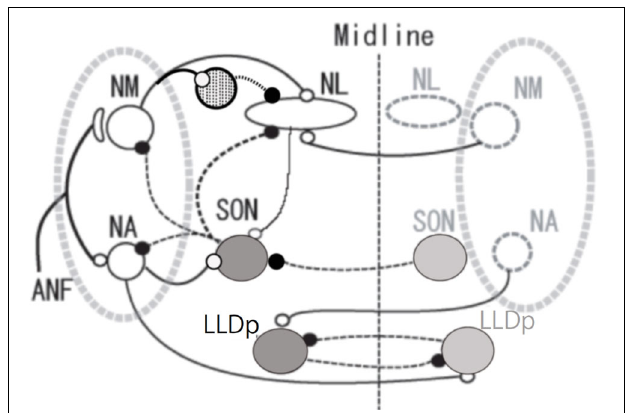
FIGURE 1 | Schema of avian auditory brainstem nuclei. Symbols indicate as follows: large open circles (excitatory neurons), large gray circles (inhibitory neurons), small open circles and solid lines (excitatory inputs) small filled circles and dashed lines (inhibitory inputs), and circle filled with dots (local inhibitory neurons). The local inhibitory neurons receive monosynaptic excitatory input from the ipsilateral NM. ANF, auditory nerve fiber; NM, nucleus magnocellularis; NA, nucleus angularis; NL, nucleus laminaris; SON, superior olivary nucleus; LLDp, posterior part of dorsal lateral lemniscus